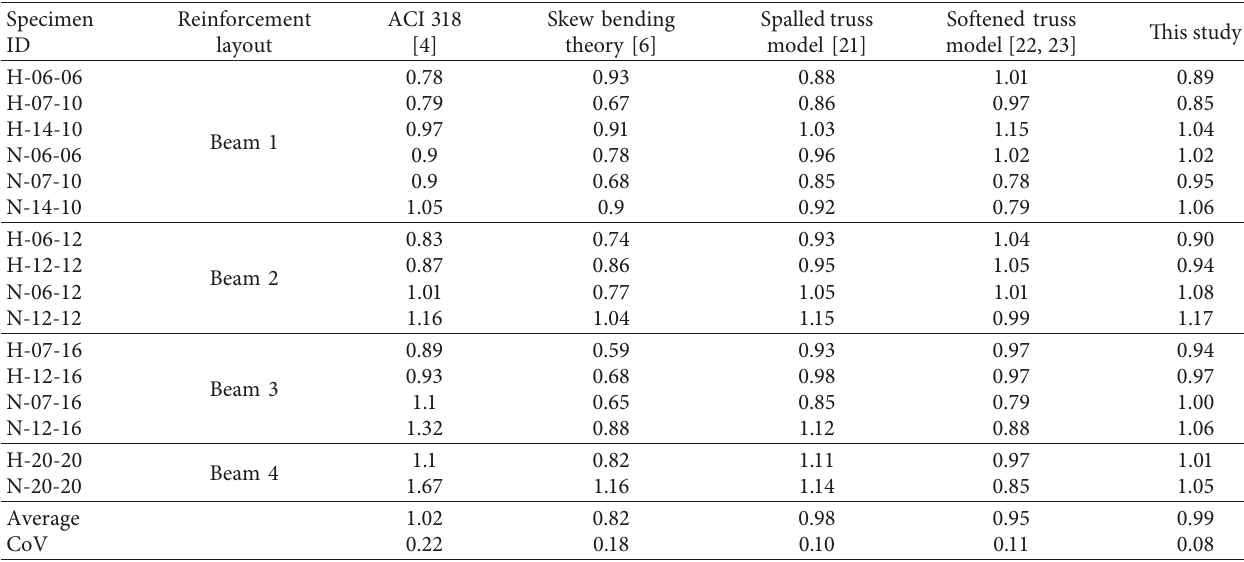
Table 3: Comparison of calculated and experimental ultimate torques (reproduced from